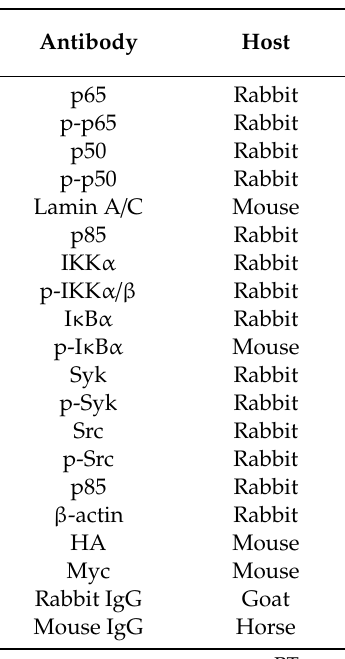
Table 1. Characteristics of antibodies (host, concentration, and exposure